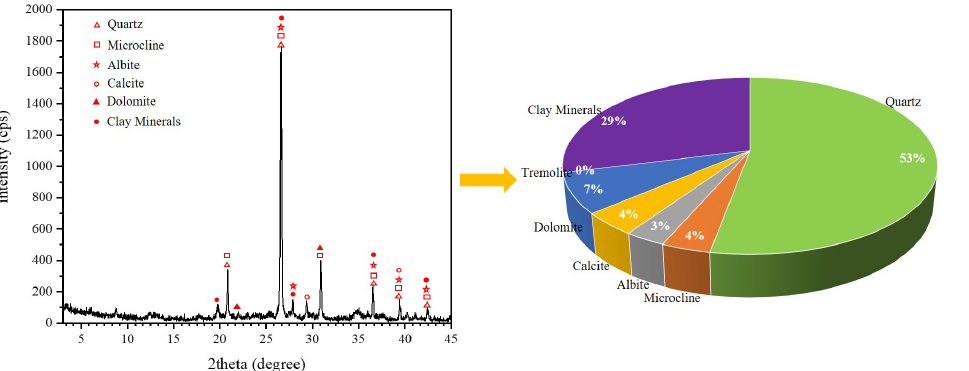
Figure 7. XRD test analysis of 145m elevation